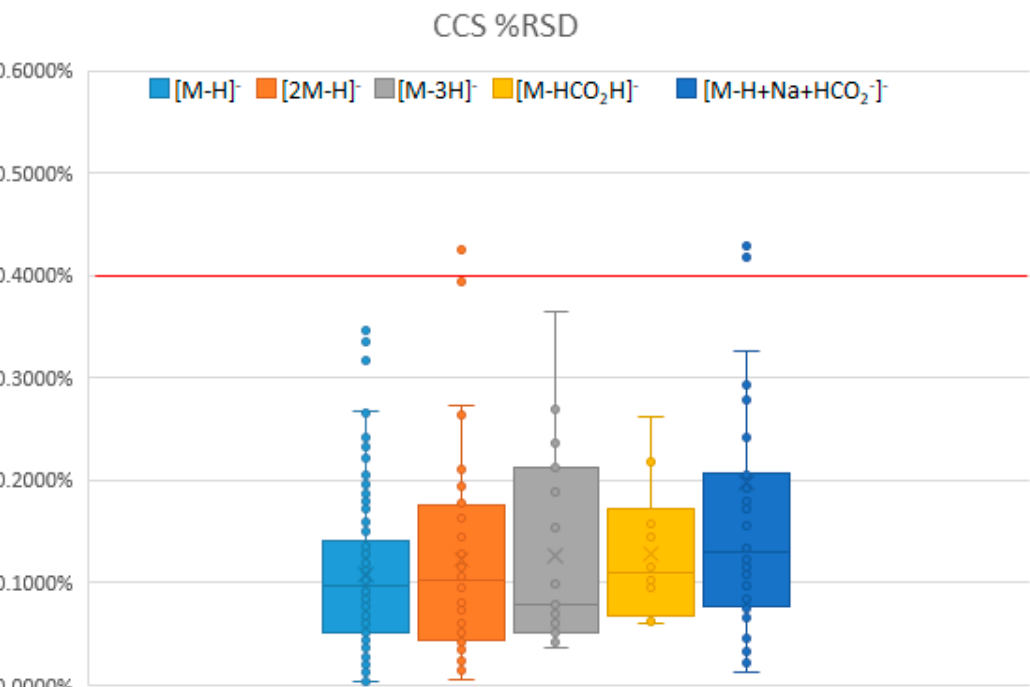
Figure 2. The percent relative standard deviation (RSD) for various collision cross section (CCS) measurements organized by ion annotations: [M-H] − ( n = 146), [2M-H] − ( n = 44), [M-3H] − ( n = 19), [M-H + HCO 2 H] − ( n = 10), and [M-H + Na + HCO 2 − ] − ( n = 37). The average relative standard deviation of triplicate measurements for all measured authentic standards was 0.1026%. There were greater deviations associated with larger adducts i.e., [M-H + Na + HCO 2 − ] − and [2M-H] −